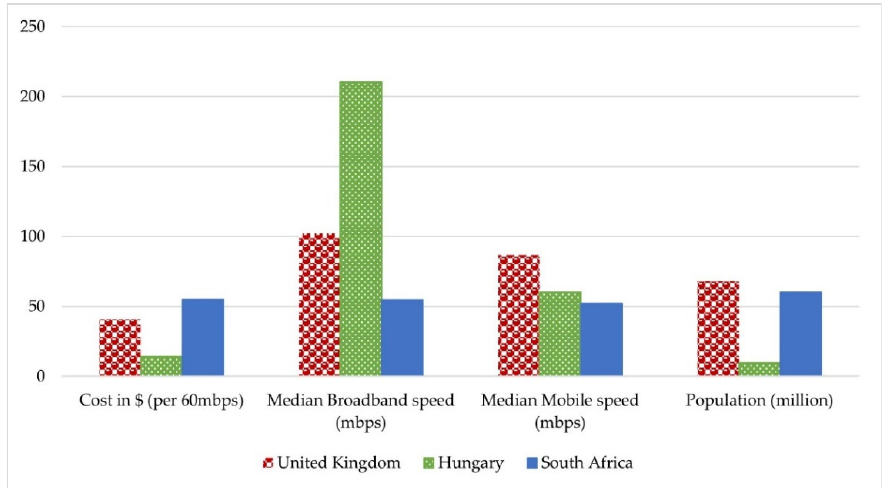
Figure 8. Internet speed and cost by country 2021